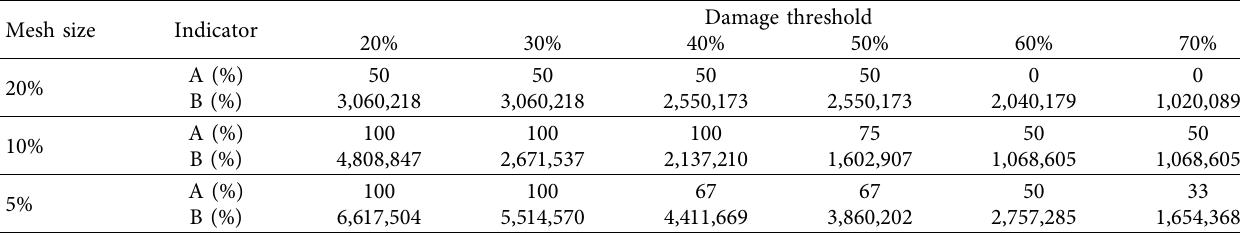
Table 7: Damage capacity indicators for extended verification using global